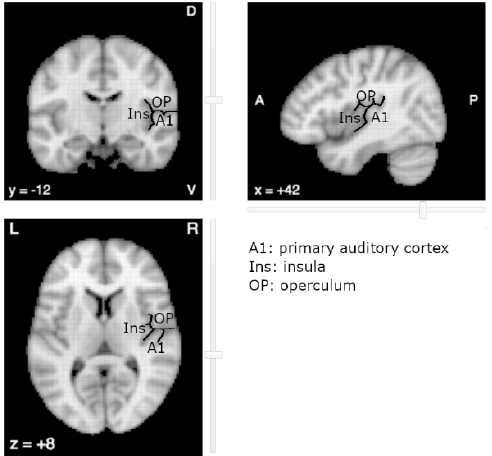
Figure 1. The auditory area (A1), parietal operculum (OP) and posterior Insula (Ins) lie on opposite banks of the lateral sulcus (underlined in black). Image derived from neurosynth.org (last accessed on 1 September 2021).